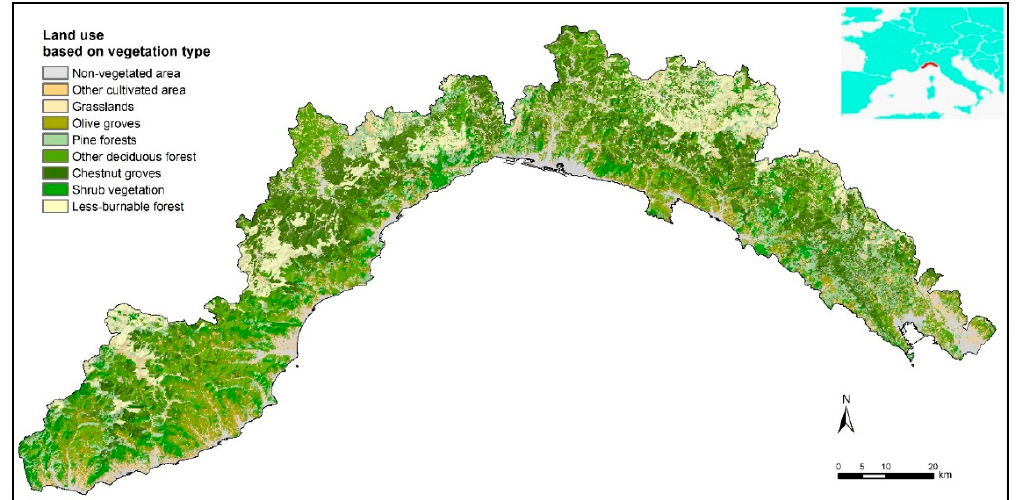
Figure 1. Study areas with the location map. Land use results from the aggregation of the original classes represented on the regional map of forest types, provided by the Liguria region .